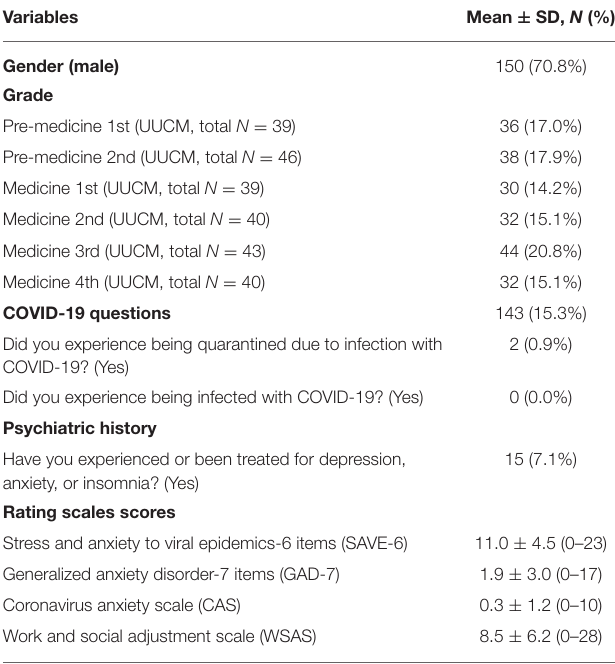
TABLE 1 | Demographic characteristics of participants ( N =